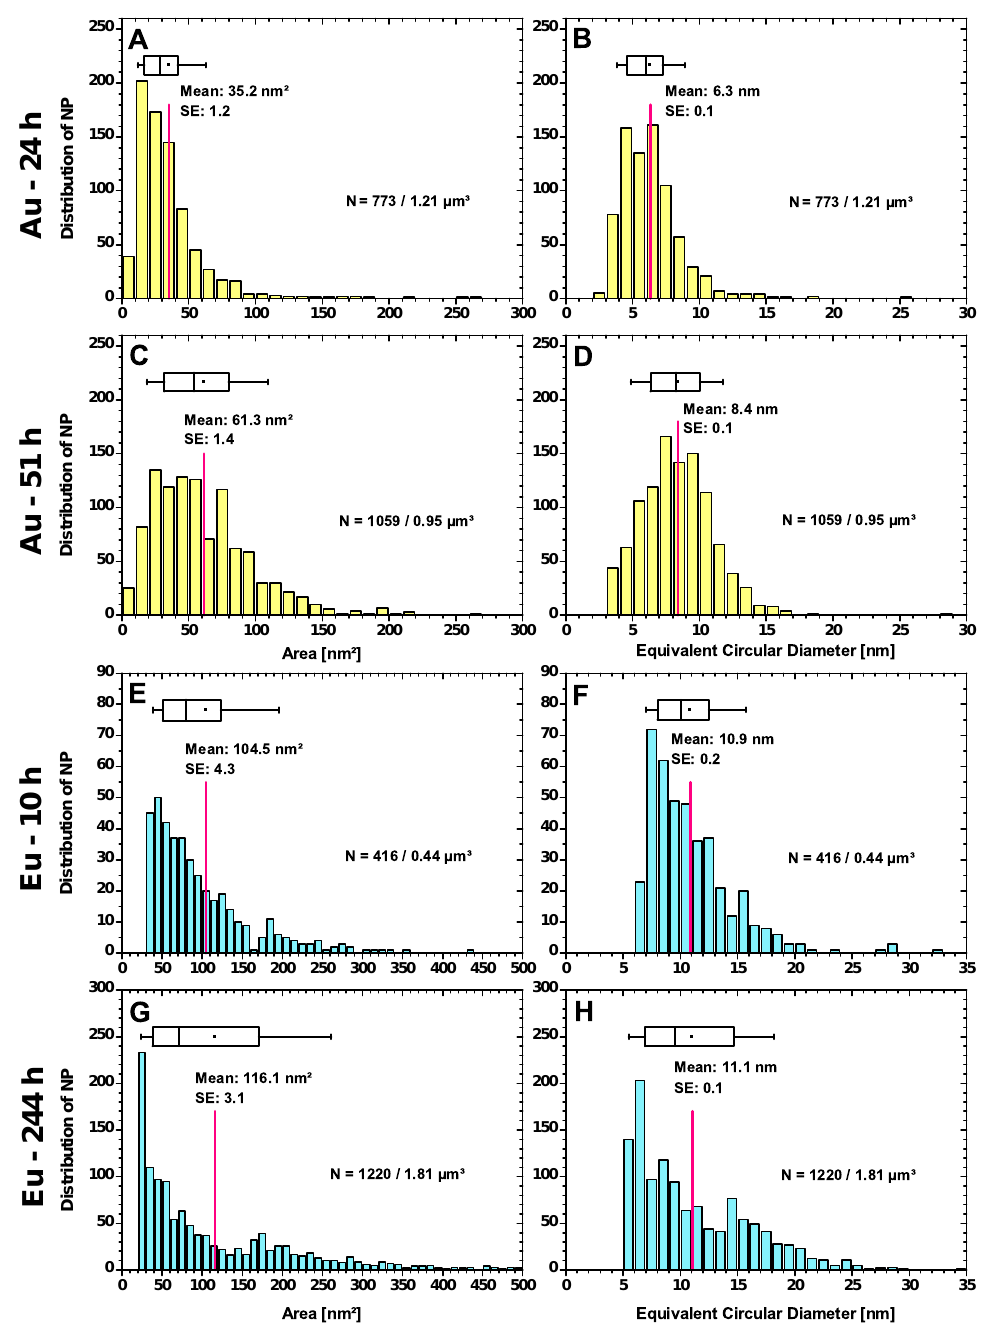
Figure 2. PSDs for Au-NPs after 24 h ( A , B ) and 51 h ( C , D ) and for Eu-NPs after 10 h ( E , F ) and 244 h ( G , H ) with the mean value and standard error (SE). The number of particles N per investigated cell volume and the average area or ECD (red lines) are indicated in the plots. The ECDs are calculated from the areas assuming round particles. The boxplots show the 25% and 75% percentiles, with the whiskers at 10% and